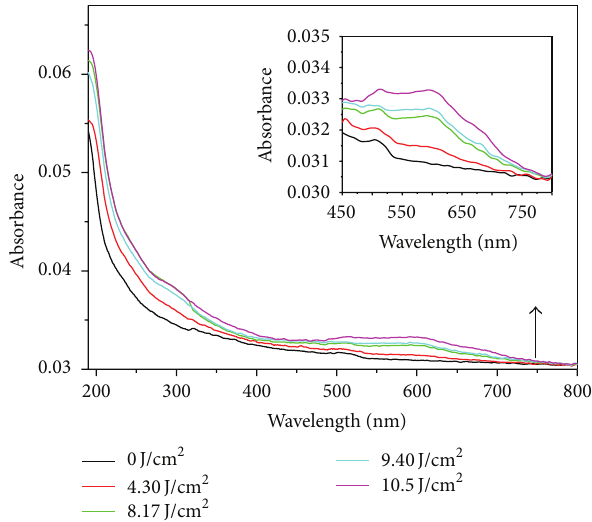
Figure 1: Absorption spectra of fused silica preirradiated in vacuum with 100 pulses at different laser pulse energies (0J/cm 2 , 4.3 J/cm 2 , 8.17 J/cm 2 , 9.40 J/cm 2 , and 10.5 J/cm 2 ). The sample exhibits absorp- tion between 500 nm and 700 nm.